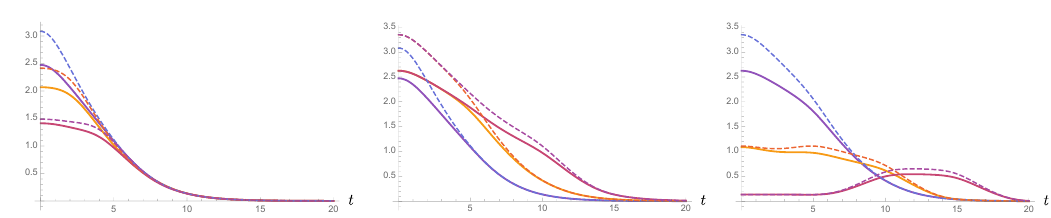
Figure 7 . The time dependent piece of E (3) (solid) and I (3) (dashed) are shown for the same parameters as (cid:12)gure 6 using (3.25). The convergence of the two quantities at late times is noted. A preliminary interpretation may be that the classical information is lost prior to the quantum information.